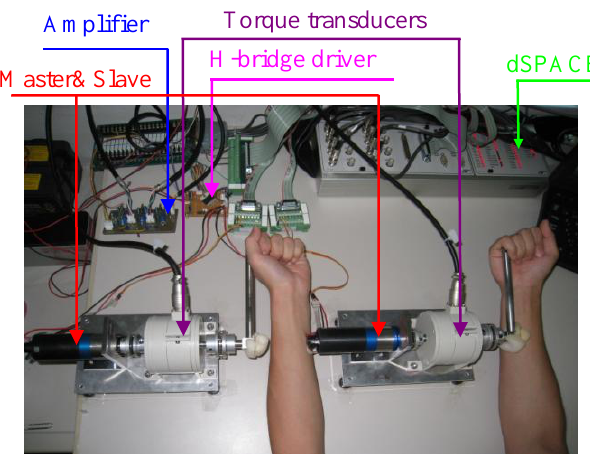
Figure 2. Experimental schematic for bimanual coordinated